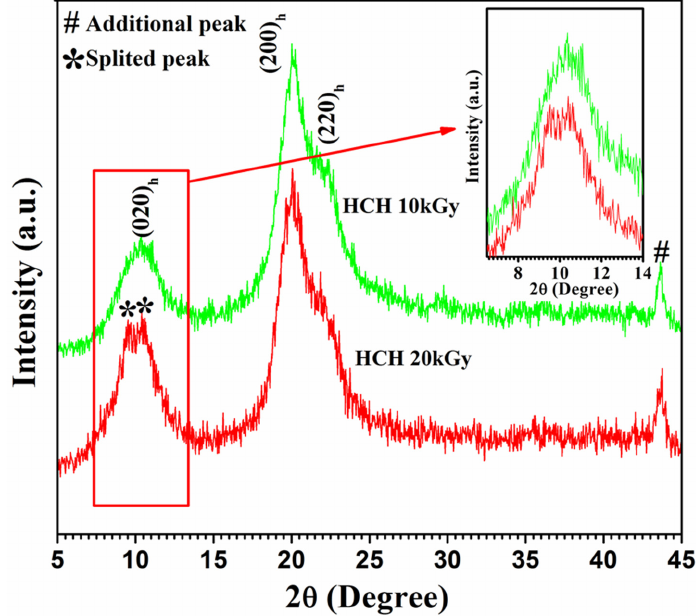
Figure 3. X-ray diffraction (XRD) patterns of HCH irradiated at 10 and 20 kGy.